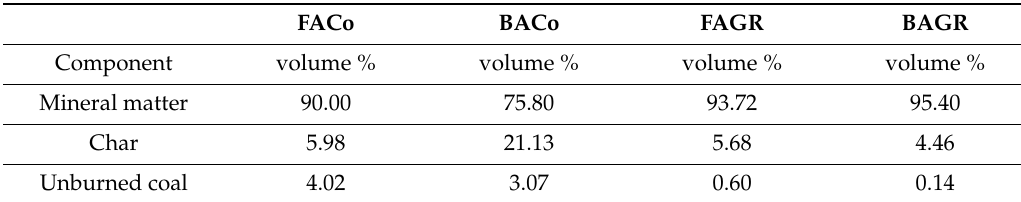
Table 4. Percentages of components in fly and bottom